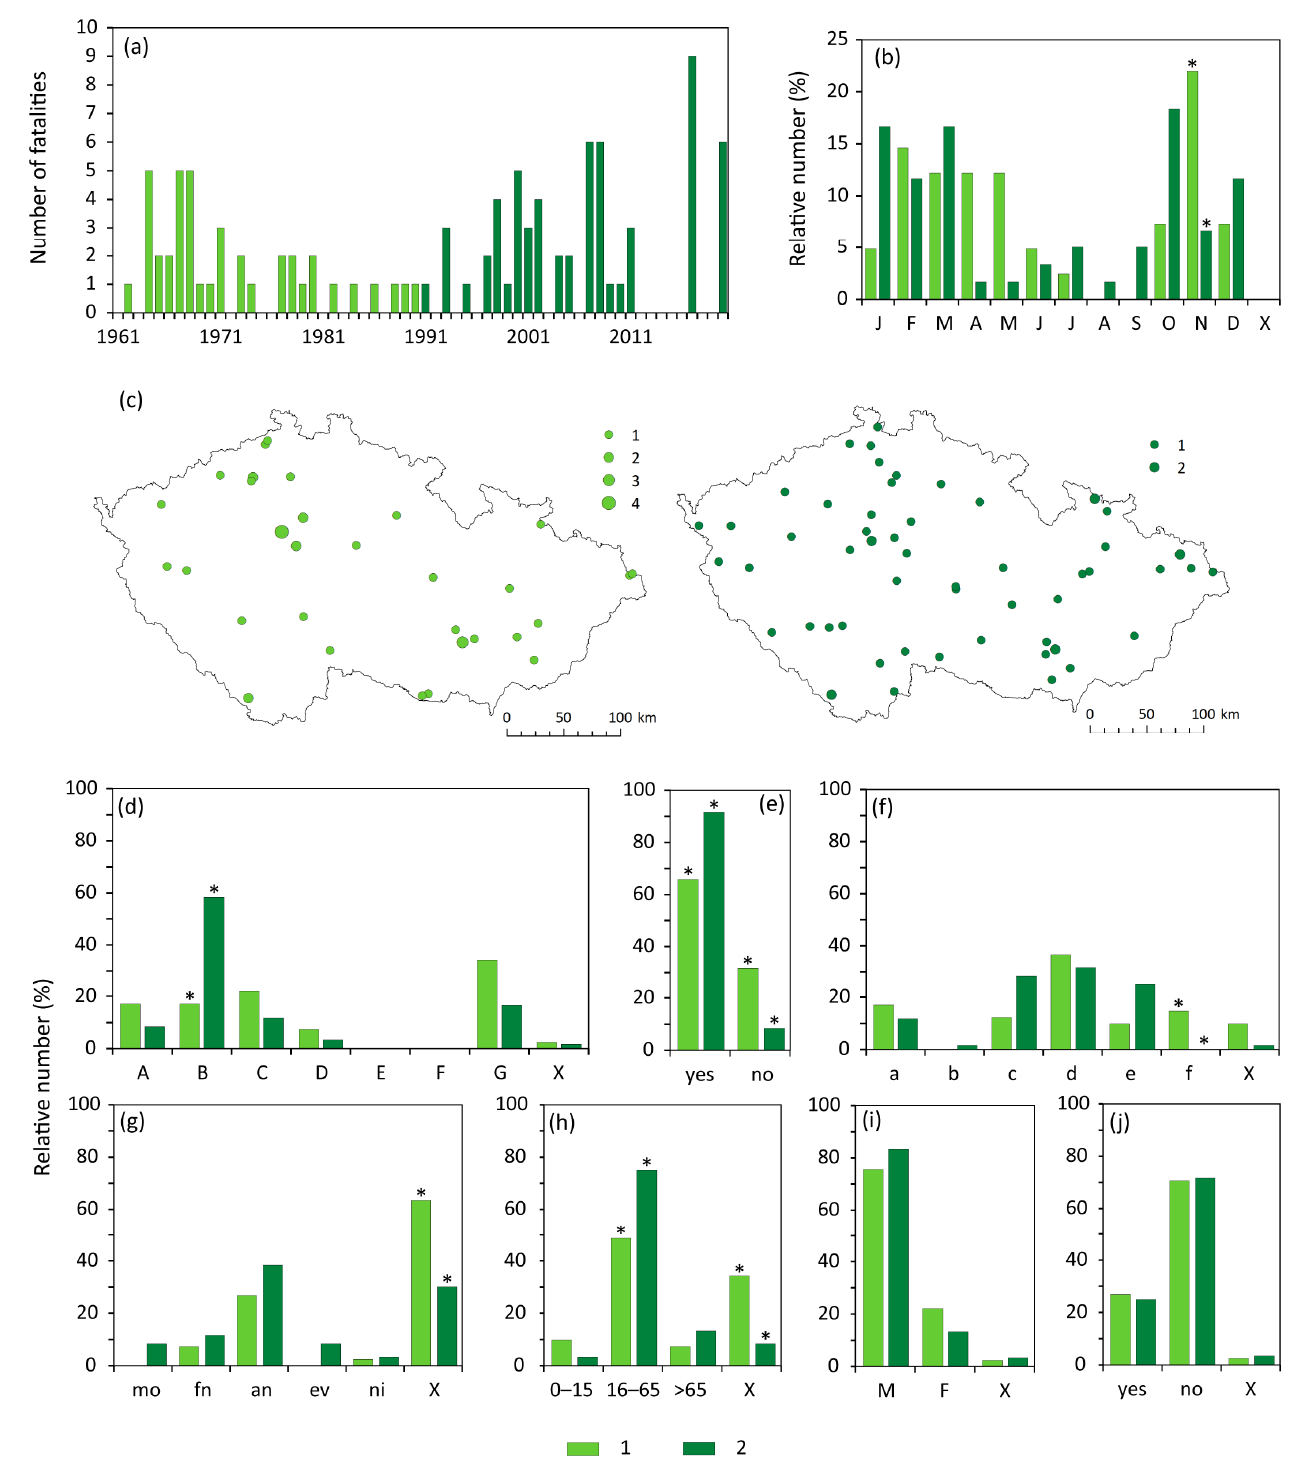
Figure 3. Characteristics of windstorm-related fatalities in the Czech Republic during the 1961–1990 (1) and 1991–2020 (2) periods. ( a ) Fluctuations in 1961–2020; ( b ) annual variation; ( c ) spatial distri- bution (one fatality in 1961–1990 and two fatalities in 1991–2020 lack exact location); ( d ) cause of death; ( e ) type of fatality (direct); ( f ) place of death; ( g ) time of day; ( h ) age; ( i ) gender; ( j ) behaviour (hazardous). For an explanation of symbols and abbreviations see Figure 2.